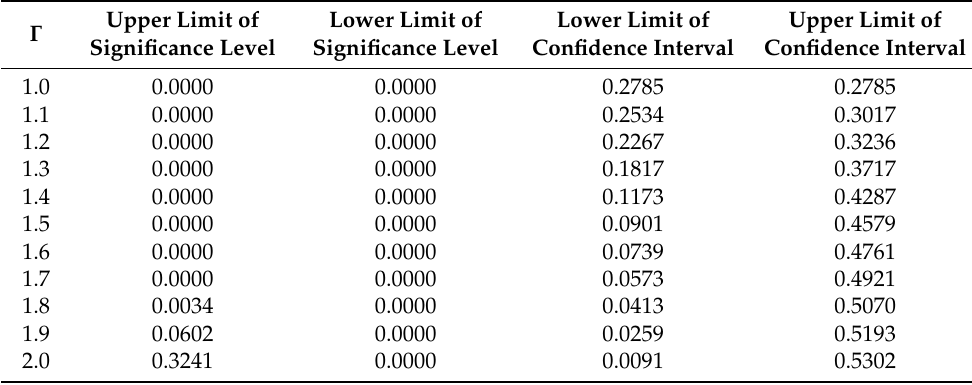
Table 6. Rosenbaum’s boundary test